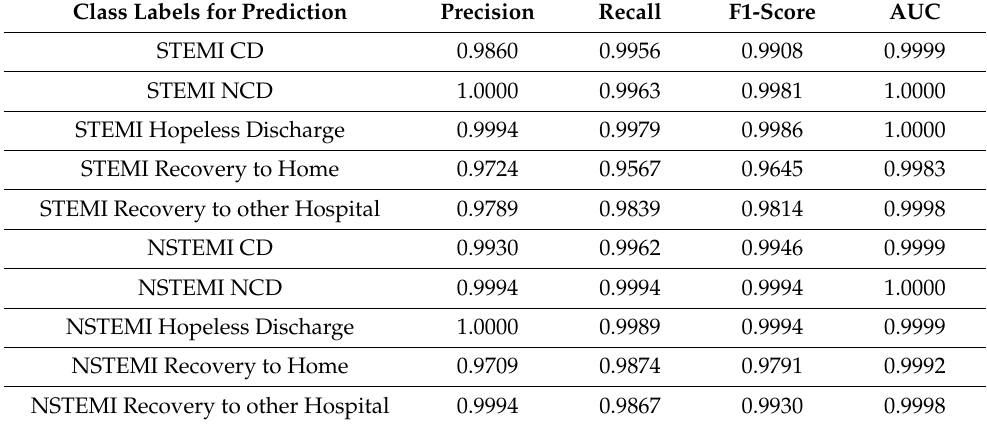
Table 4. Performance measures of all class labels for Extra Tree Classifier using in-hospital data.